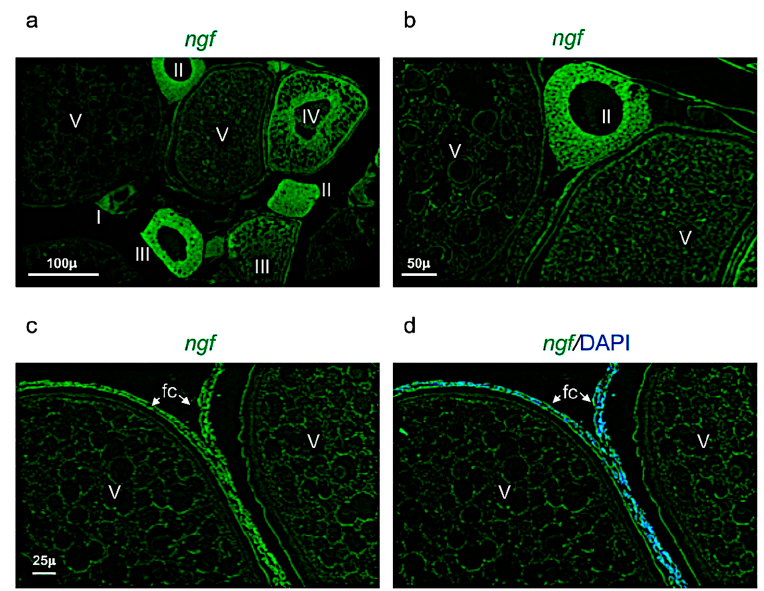
Figure 7. Ngf expression pattern in adult zebrafish ovary. ( a ) Fluorescence in situ hybridization of ngf in adult zebrafish ovary, mainly expressed in oocyte at different stages: II-III-IV and in follicular cells of stage V. ( b ) Fluorescence in situ hybridization of ngf in oocytes at II and V stages. ( c ) Fluorescence in situ hybridization of ngf , high magnification of follicular cells in oocyte at stage V. ( d ) Fluorescence in situ hybridization of ngf and cell nuclei (DAPI) , high magnification of follicular cells in oocyte at stage V. Scale bars: 100 µ ( a ); 50 µ ( b ); and 25 µ ( c , d ).